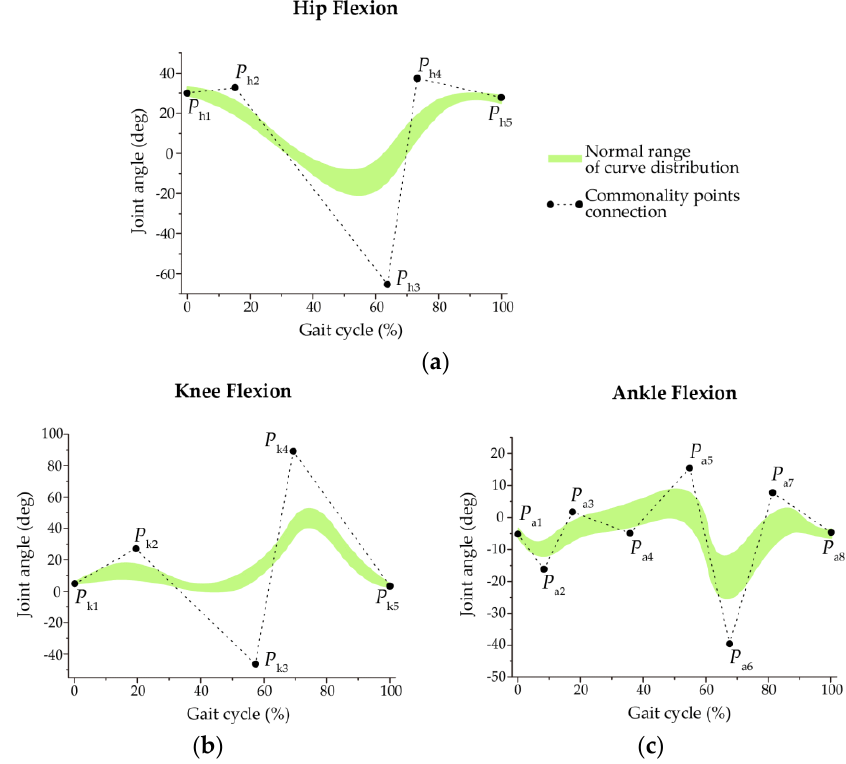
Figure 6. The determined commonality points and normal ranges of angle curves from the normal group after comparison of the fitting results: ( a ) P h1 , …, P h5 connected by a dotted line are the five commonality points of hip joint, which means there were three shape parameters according to the model. The light green area shows the shape distribution of 10 curves and as the hip normal distribution range; ( b ) There were also five commonality points ( P k1 , …, P k5 ) and three shape parameters of knee joint curves in one gait cycle; ( c ) The ankle joint curves were provided with eight commonality ( P a1 , …, P a5 ) points and six shape parameters.